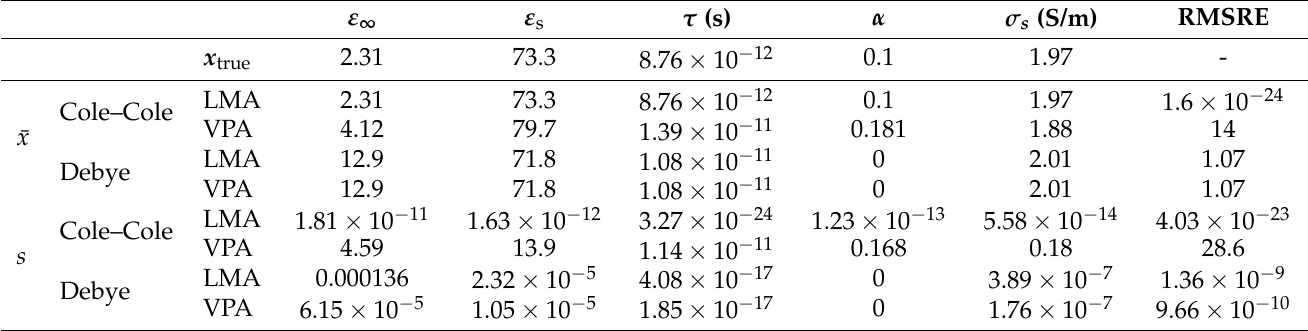
Table 6. Statistical diagnostics on fitting results. Set C of the initial points and 250 mg/dL glucose concentrations were